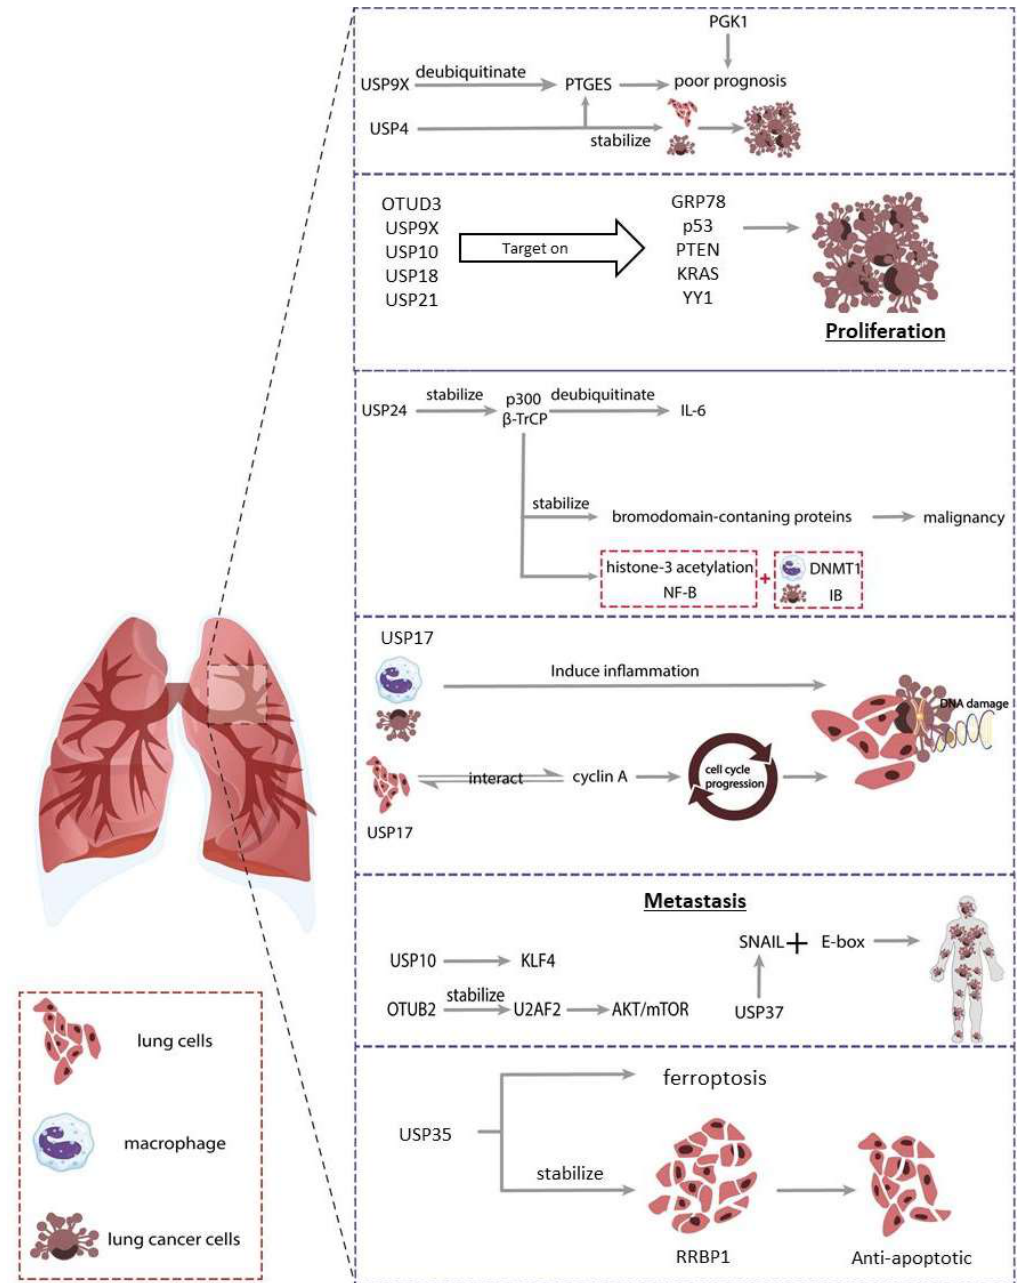
Figure 4. Roles of deubiquitinases (DUBs) in lung cancer. Various DUBs are found to be involved in lung cancer. DUBs control proliferation via various targets. For example, USP4, and USP9X target on PTGEs, while OTUD3, USP9X, USP10, USP18, and USP21 binds with GRP78, p53, PTEN, KRAS, and YY1 respectively. Besides, USP24 regulates inflammation and cell migration via stabilizing p300 and BRDs. Furthermore, USP17 induces inflammation and regulates cell cycle that links to DNA damage mechanism. Moreover, DUBs such as OTUB2, USP10, and USP37 regulate metastasis via U2AF2, KLF4, and SNAIL respectively. Lastly, USP35 stabilizes RRBP1 and controls the apoptosis. Detailed mechanisms can be referred back to the main